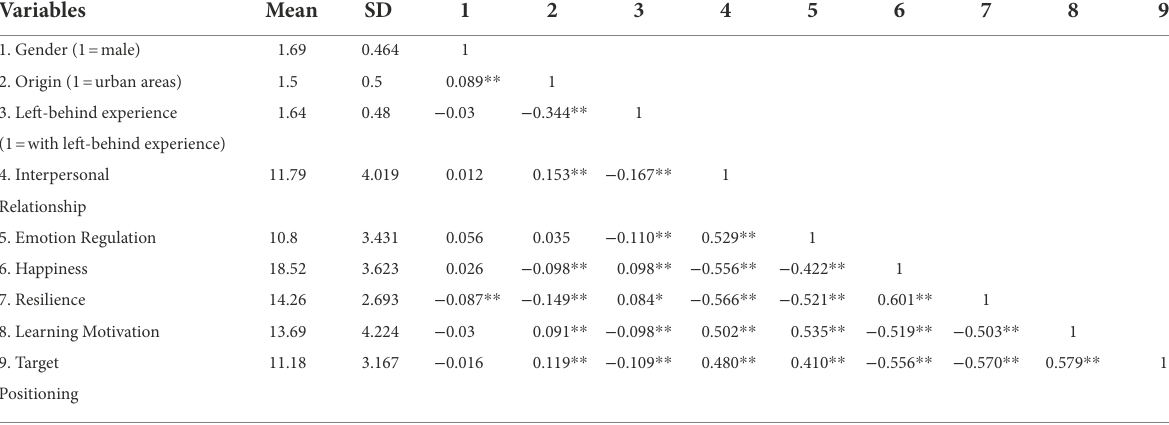
TABLE 3 Description statistics and